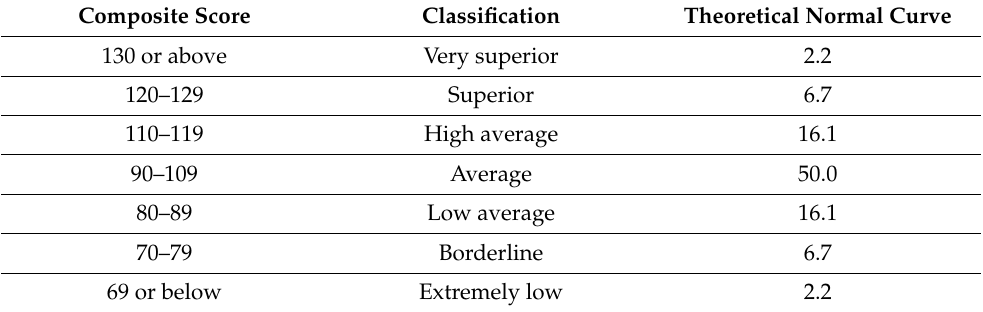
Table 2. Qualitative Description of Composite